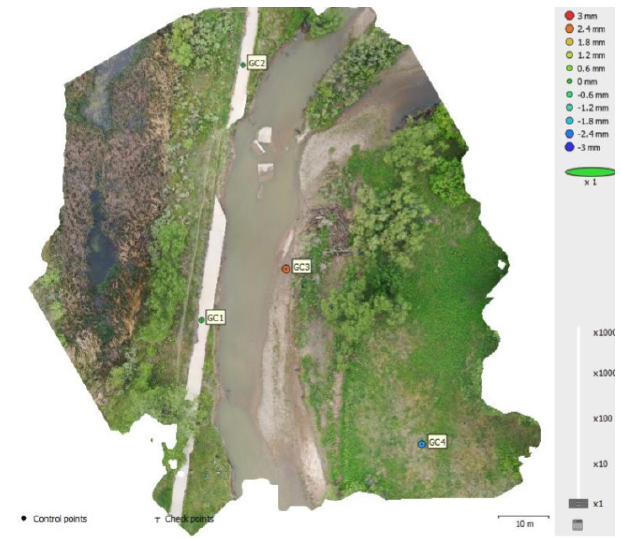
Figure 7. Student-generated colored SfM point cloud of their area of interest showing GCP error ellipsoids used by the student in their SfM error analysis (created by student in course; student not dis- closed to comply with Institutional Review